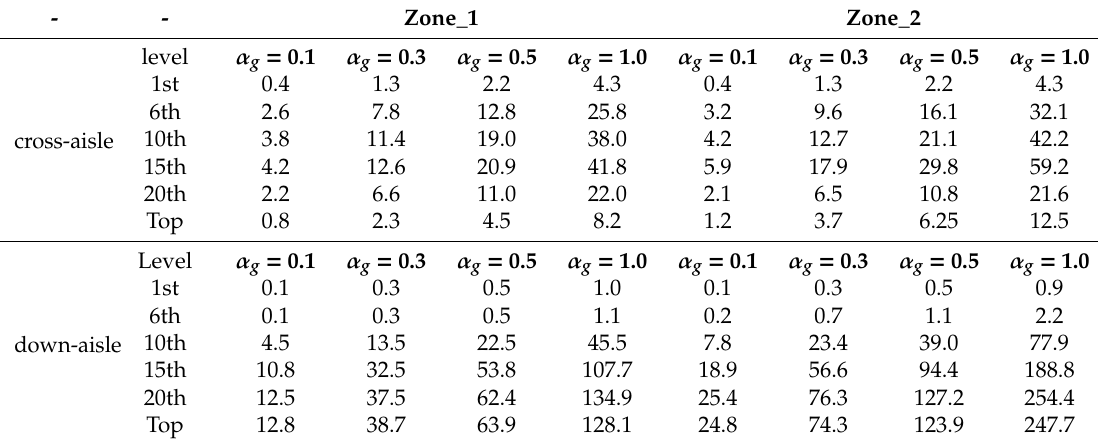
Table 3. Maximum displacements obtained from MRSA (in